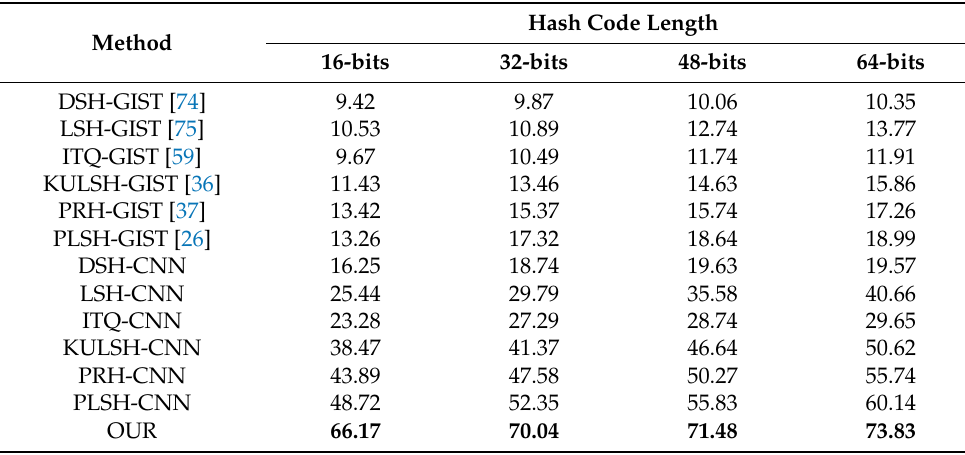
Table 3. MAP retrieval results on the AID dataset; we give separate hash retrieval results for 16, 32, 48, 64 bits. The testing set has 5000 images (each category randomly takes 50% of the